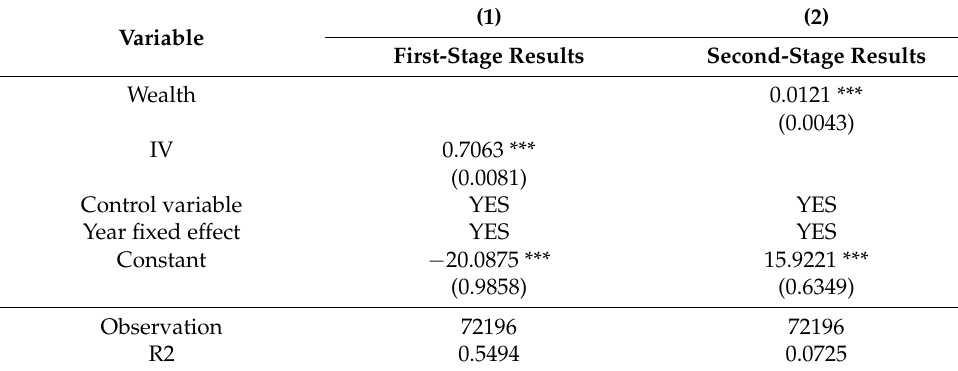
Table 3. 2SLS estimation results.